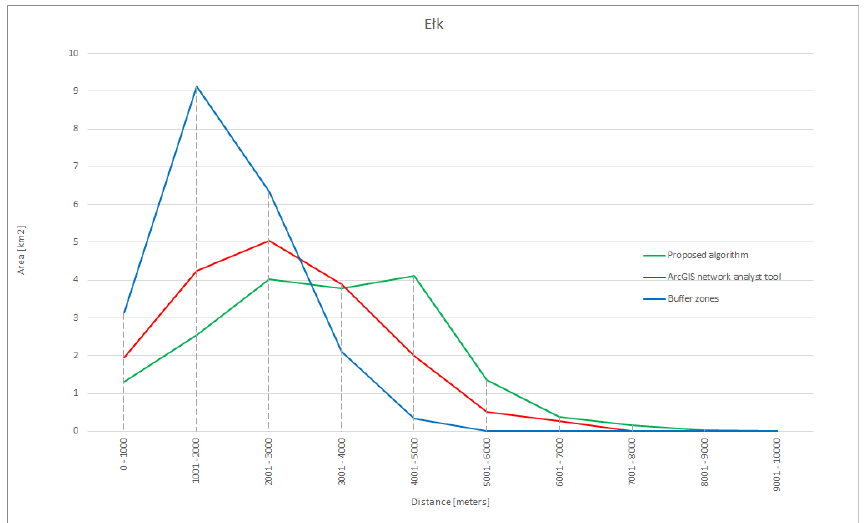
Figure 13. The results generated by different methods for identifying service areas in the city of Olsztyn.